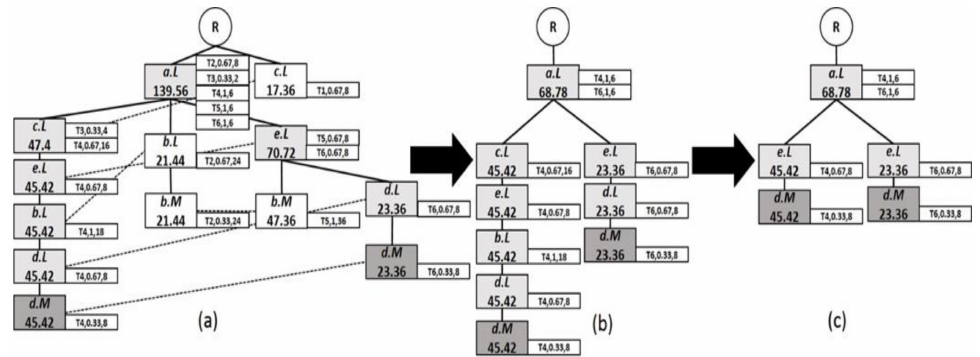
Figure 5. The conditional pattern tree for the linguistic term ( d.M ). ( a ) The whole frequent pattern tree; ( b ) The two branches for ( d.M ); ( c ) The final conditional pattern tree for ( d.M